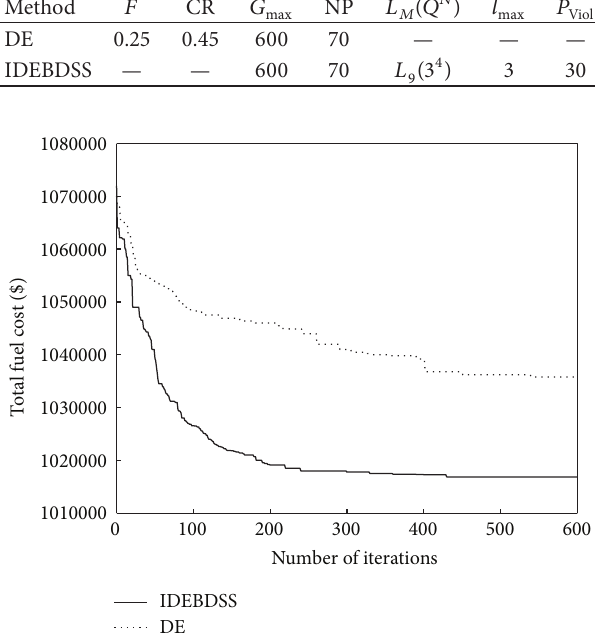
Table 1: Parameter settings for IDEBDSS and DE. Method